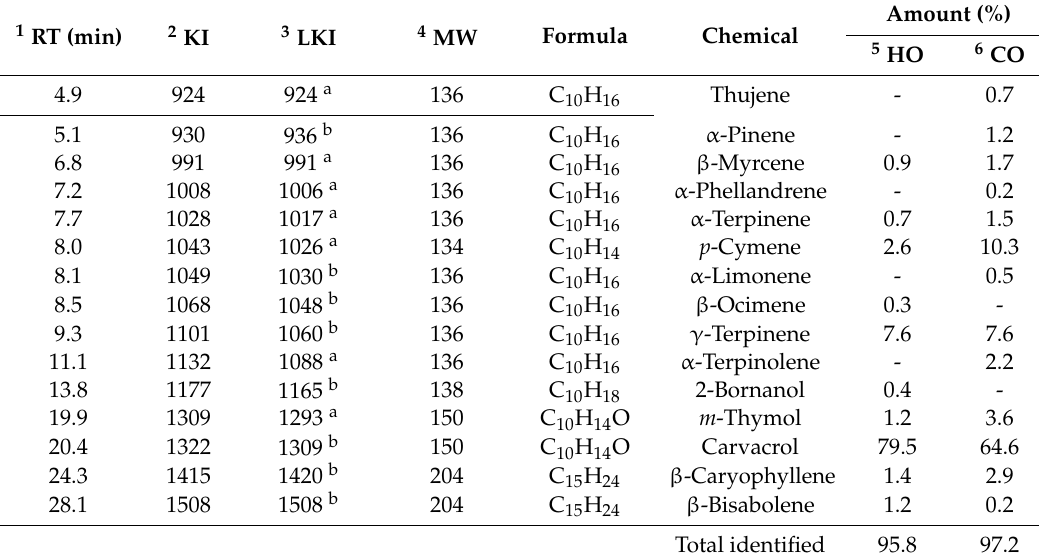
Table 2. Chemical compositions of O. vulgare oils. Their percentage composition and their Kovat Index (KI) values listed in order of elution.